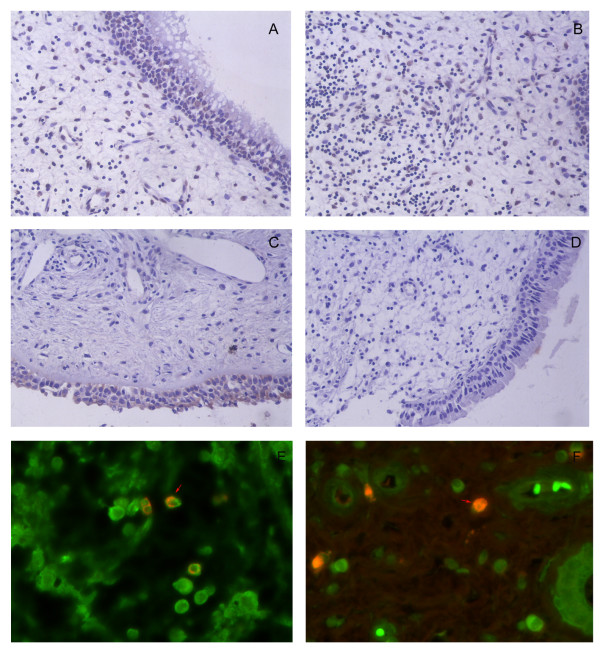
Infiltration of pmTOR+ cells and Foxp3+CD4+ cell in nasal tissues by histologic examination. The number of pmTOR+ cells was significantly higher in nasal polyps than in controls, whereas the number of Foxp3+CD4+ cells was significantly lower in nasal polyps than in controls. Representative images are provided and the results were analyzed by the unpaired t-test. (A), The pmTOR+ cells were located in both the epithelium and submucosa of nasal polyps; (B), Expression of pmTOR was primarily located in the submucosa of nasal polyps; (C) Immunostaining of pmTOR was localized primarily to the epithelium in control tissues; (D), Negative control for pmTOR staining in nasal polyps (200× magnification). (E and F), Foxp3+CD4+ cells were located in nasal polyps (E) and the control tissue (F), as evidenced by double immunofluorescence (400× magnification); CD4 FITC (green); Foxp3 Texas red (red); double-positive stain (arrow, orange).